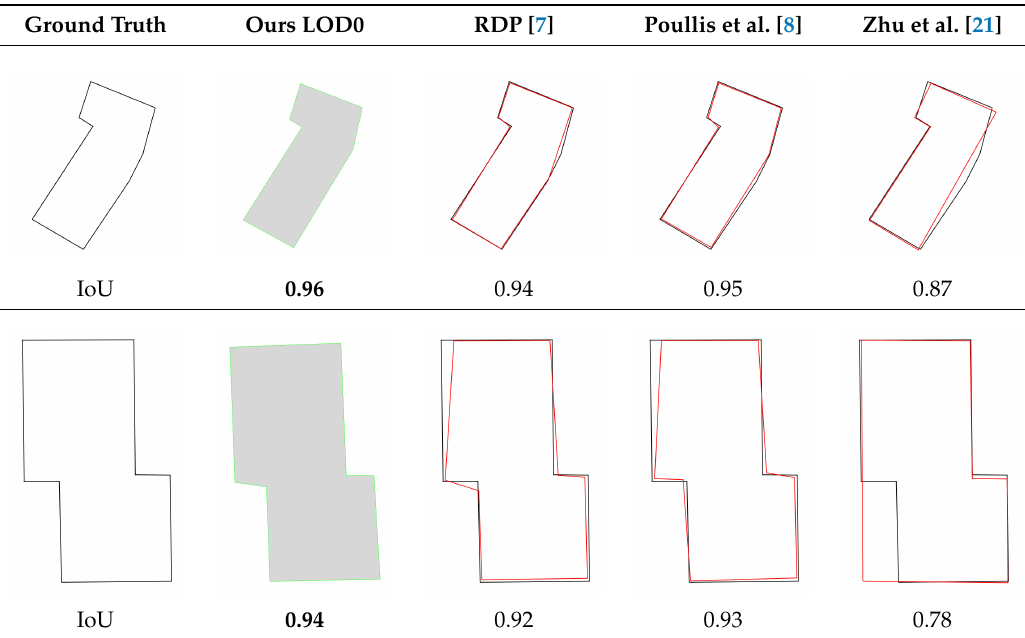
Table 1. Contour quality comparison of different methods on the building in Figure 3. In each row from left right to left are: the ground truth building contour provided by ISPRS [6], the our LOD0 model, the RDP algorithm [7] output by specifying the number of vertexes to be the same as ours, the result by Poullis et al. [8], and Zhu et al.